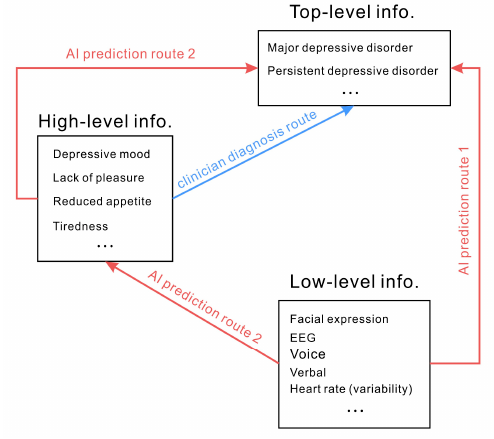
Figure 2. In the diagnostic criteria for depressive disorders, subjective experiences or qualitative descriptions (i.e., high-level information) are often used (clinician diagnosis route). AI generally tries to predict top-level with low-level information directly (route 1). There is also another possible route (route 2, not commonly used) that AI can predict high-level information first and then infer the top-level